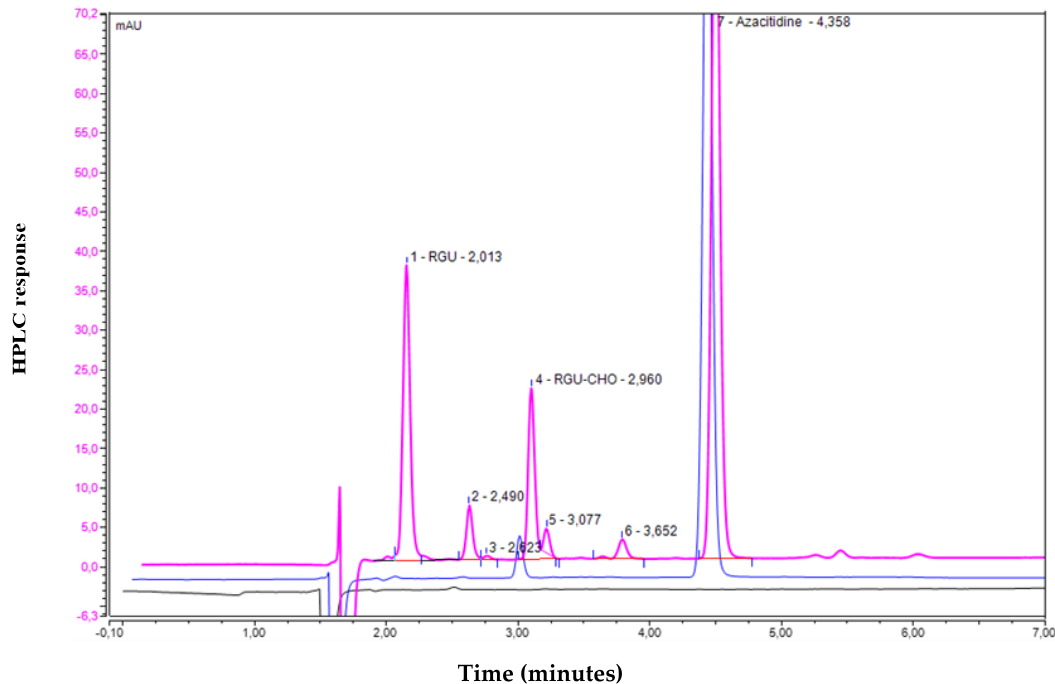
Figure 1. Chromatogram showing the peak related to water for injection (black line); chromatogram showing the peak related to azacitidine (50 µg/mL) standard solution freshly prepared (blue line); chromatogram of a Vidaza ® (25 mg/mL) preparation subjected to heat stress (violet line). No interfering materials were detected.